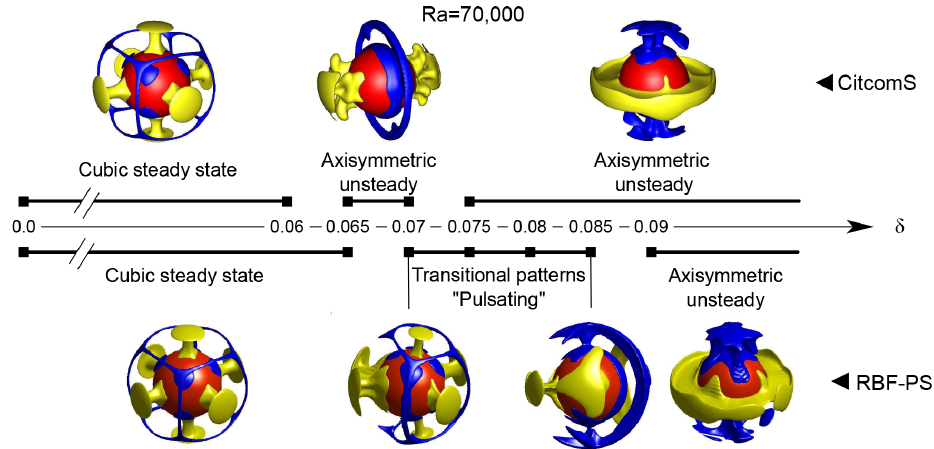
Figure 4. Stability of the cubic steady state at Ra = 70000 with CitcomS (up row) and the RBF-PS method (bottom row). The cubic steady- state pattern is destabilized for δ ≥ 0 . 065 with CitcomS and δ ≥ 0 . 07 with RBF-PS. The figure highlights transitional patterns between the two main geometries.